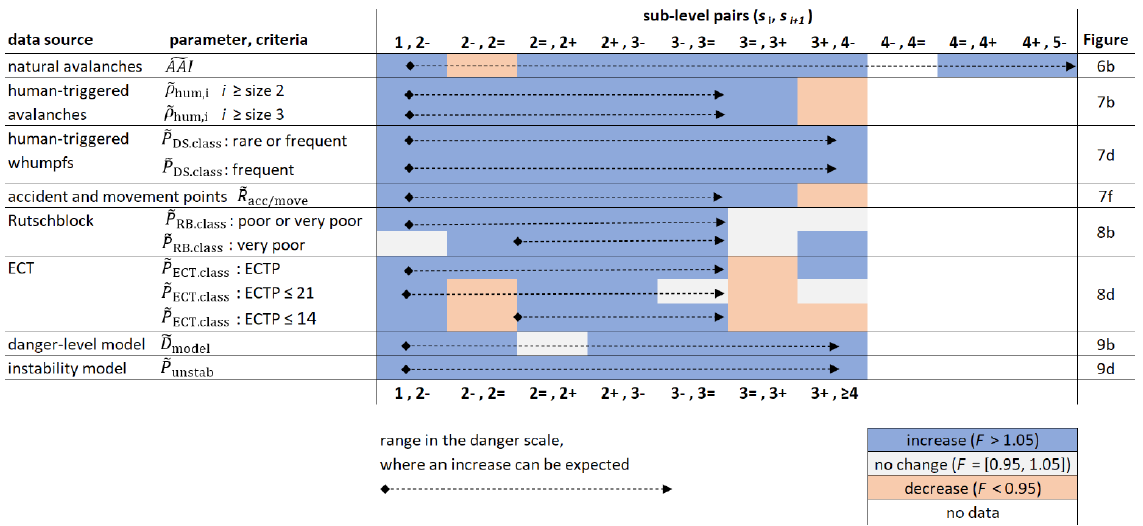
Table 4. Table summarizing whether an increase (light blue, F > 1 . 05) or a decrease (light orange, F < 0 . 95) in the median was observed from one sub-level ( s i ) to the next higher one ( s i + 1 ). The dashed arrows indicate the range, for which significant increases between neighbor- ing danger-level pairs ( D , D + 1) were observed, and where, thus, an increase between sub-levels can be expected if their relative assignment would on average be